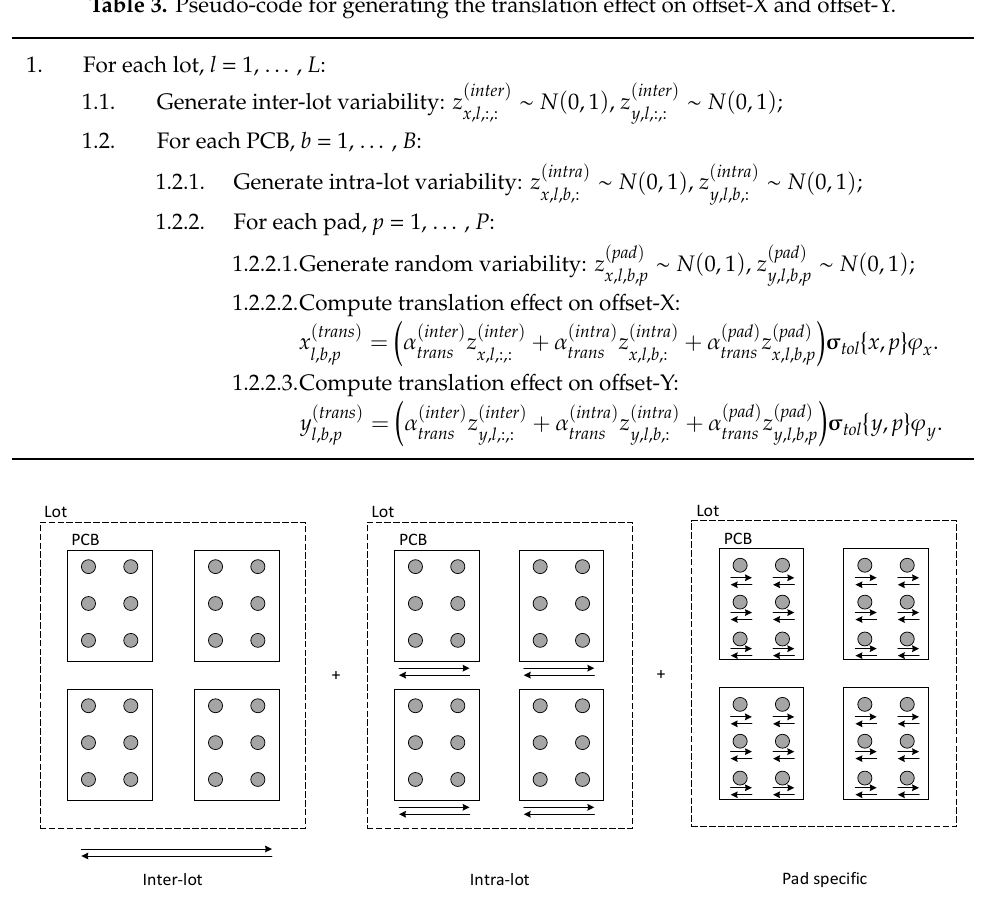
Figure 3. Schematic representation of the inter-lot, intra-lot and pad specific components used to generate the translation effect on offset-X.